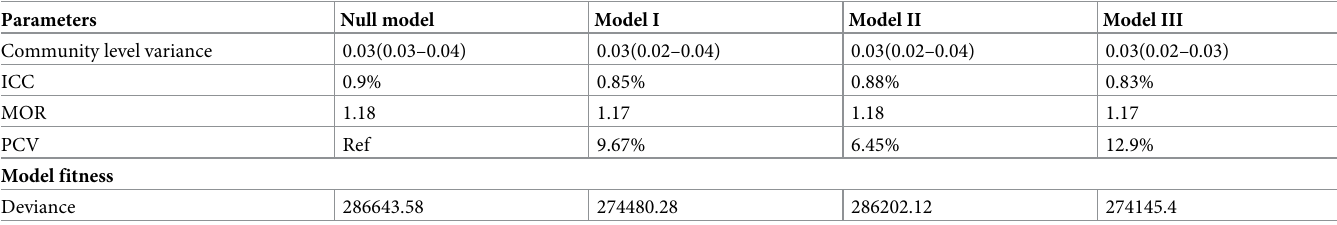
Table 4. Model comparison and random effect analysis